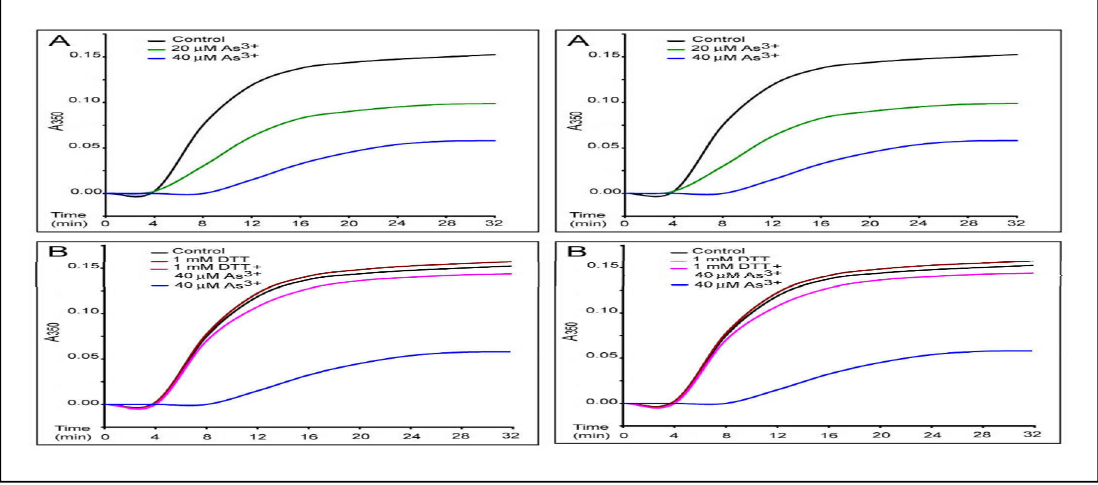
Figure 5. As 3+ -inhibition of MT protein polymerization in vitro as revealed by the turbidity assay. The in vitro polymerization of MT proteins (0.8 mg/mL) in 0.1 M Pipes buffer, pH 6.6, containing 0.15 mM Mg 2+ , 0.15 mM EGTA and 500 µM GTP was monitored by turbidity readings at A at 25 °C in the absence or presence of As 3+ at indicated 350nm concentrations. Curves represent the time course of tubulin assembly under different conditions. ( A ) dose-dependent inhibition by As 3+ of MT assembly. the black curve, control; the green curve, 20 µM As 3+ ; the blue curve, 40 µM As 3+ . ( B ) DTT effects on As 3+ inhibition of MT assembly. DTT (1 mM) was added after preincubation of polymerization mixture in the presence of As 3+ for three min. the black curve, control; the brown curve, 1 mM DTT; the blue curve, 40 µM As 3+ ; the pink curve, 40 µM As 3+ plus 1 mM